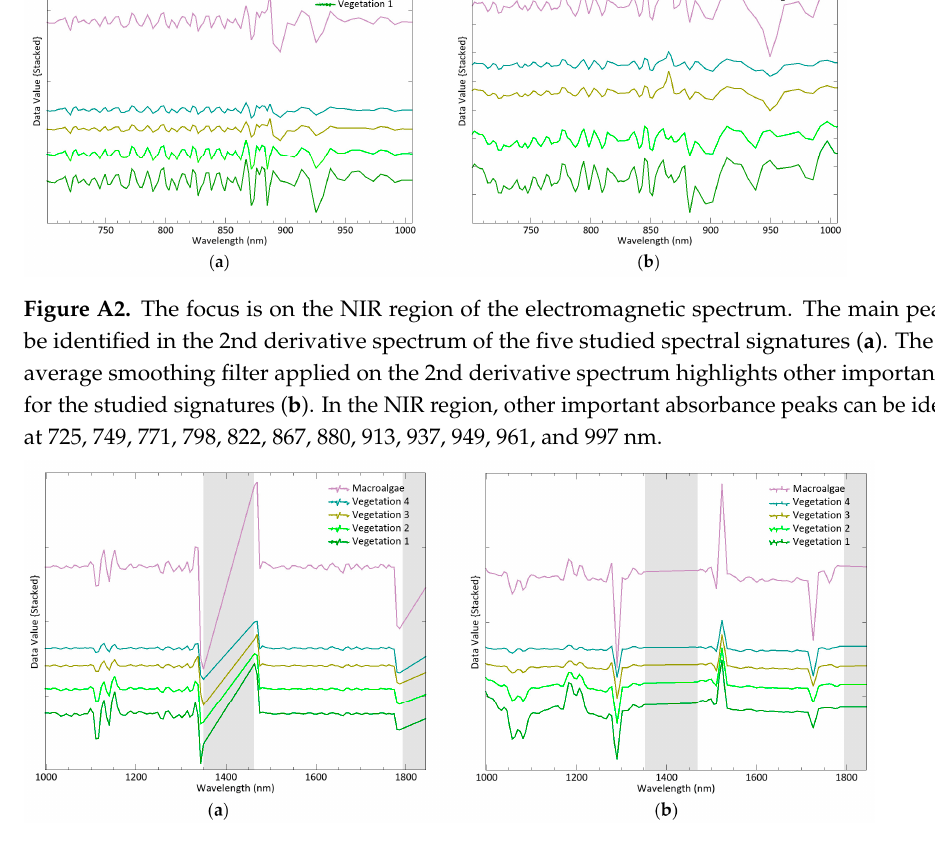
Figure A4. The focus is on the SWIR2 region of the electromagnetic spectrum. The main peaks can be identified in the 2nd derivative spectrum of the five studied spectral signatures ( a ). The boxcar average smoothing filter applied on the 2nd derivative spectrum highlights other important peaks for the studied signatures ( b ). The SWIR2 region presents absorbance peaks at 1971, 2007, 2025, 2054, 2114, 2192, 2228, 2264, 2293, and 2335 nm. In grey is one of the water vapour absorbance regions (1790–1960 nm) excluded from the hyperspectral processing. Appendix A.2. Accuracy Table A1. Report for the accuracy of the comparison of classification results to Eq250, the equalized samples groups using 250 pixels for each class as reference. The table summarizes the producer accuracy and user accuracy in percentage and pixels for each class. Class Class Name Prod. Acc. (Percent)